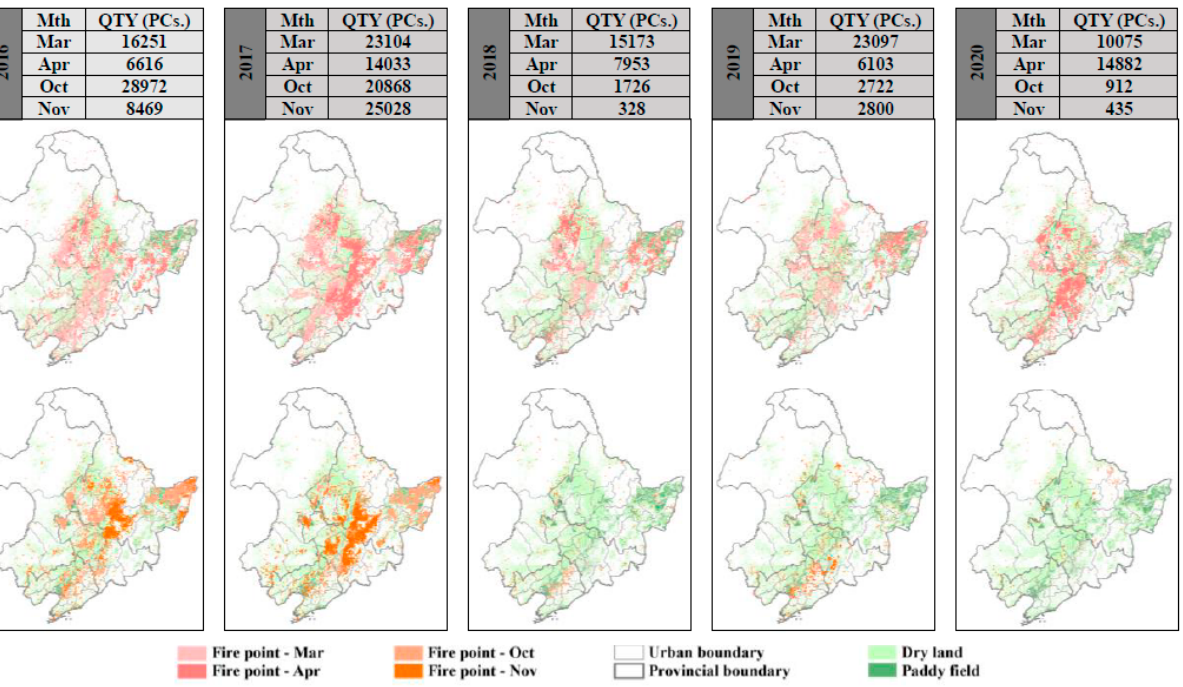
Figure 3. Statistical quantities (QTY) and distribution of fire point data in Northeast China in March, April, October and